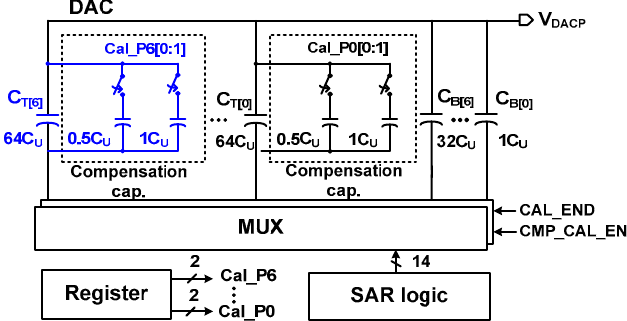
Figure 15. Schematic of compensation capacitors in the positive DAC branch.